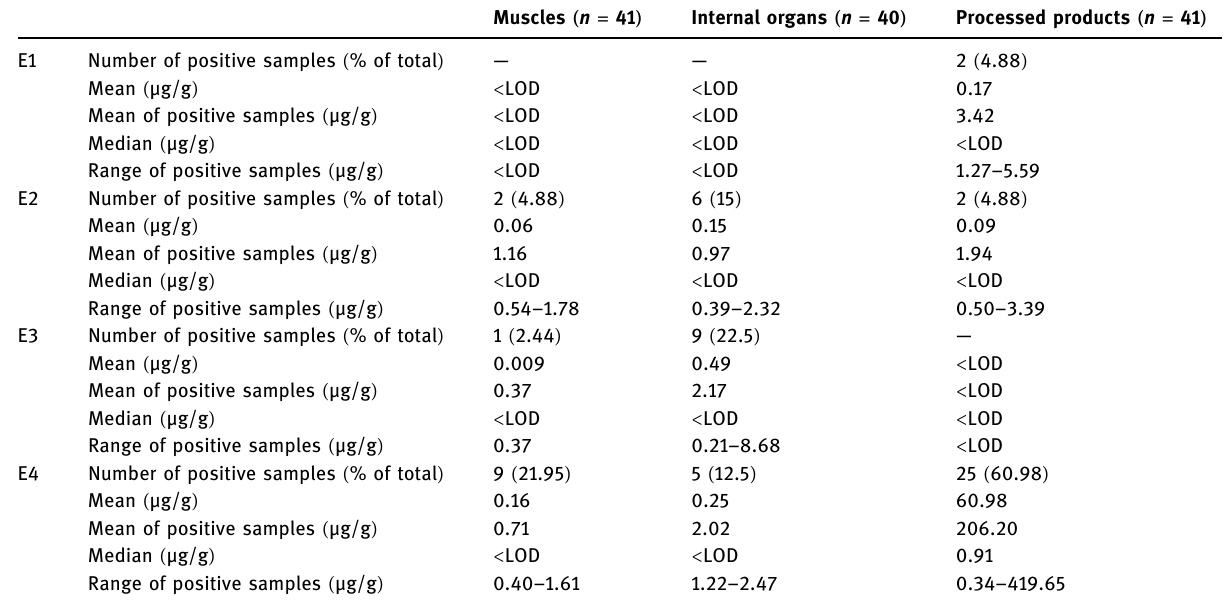
Table 5: Occurrence of estrogen residues ( µg/g ) in sheep samples